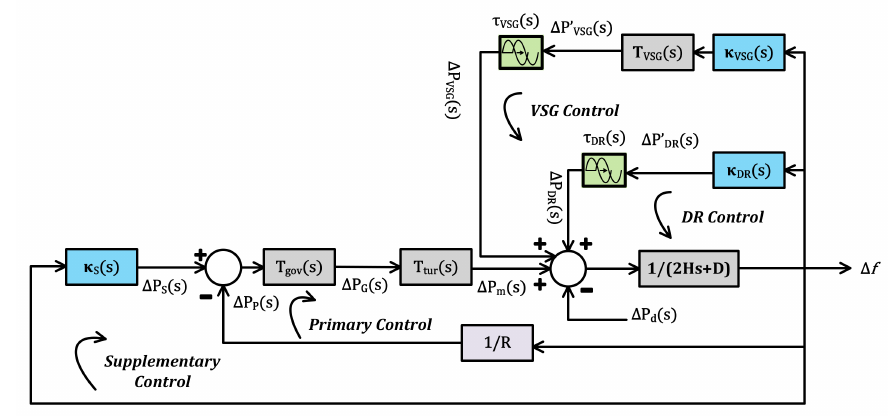
Figure 1. The block diagram of a power system for frequency response analysis including DR and VSG control